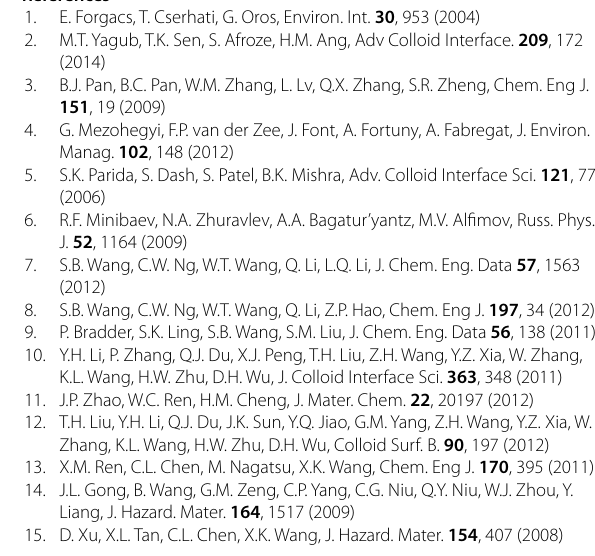
compatibility of GCCH.